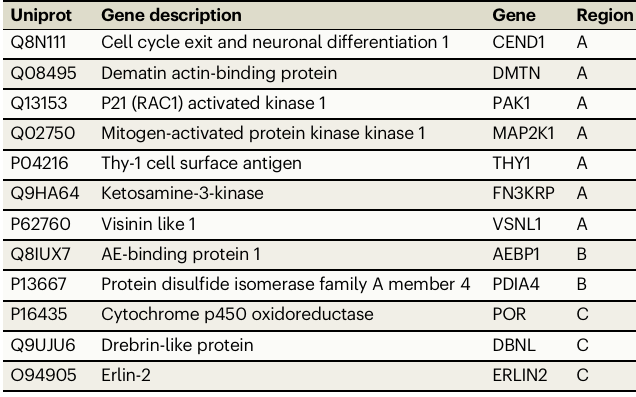
Table 2 | Proteins associated with unfavorable prognostic in glioma and identi fi ed in regions A, B, and C